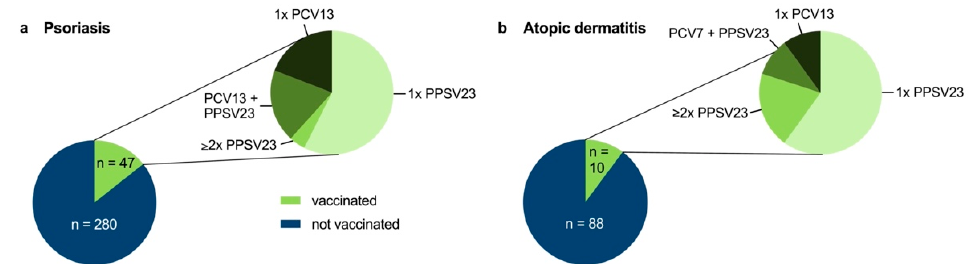
Figure 2. Pneumococcal vaccination rate in PsO and AD patients. PsO ( a ) and AD ( b ) patients with